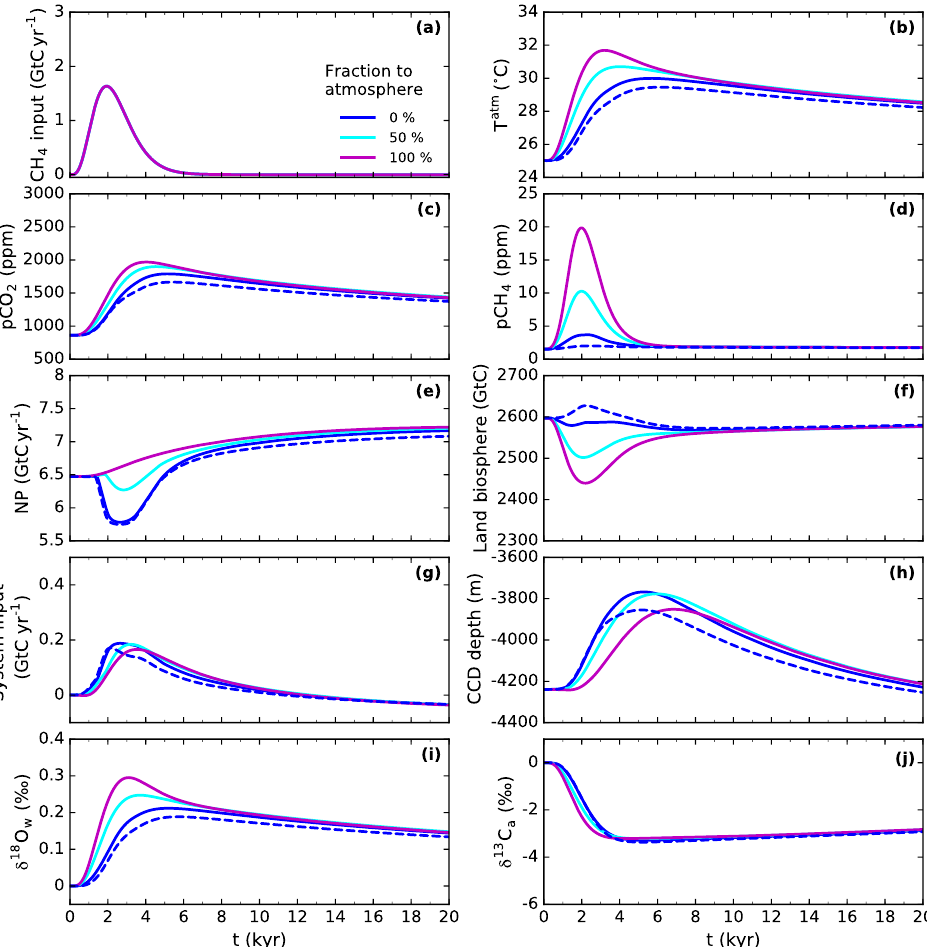
Figure 9. Results for 20000-year simulations for different fractions of methane escape to the atmosphere for a methane input of 4000GtC over a timescale of 3000 years. Properties plotted in (a–j) as in Fig. 7. Also shown are results from a simulation with all methane input to the ocean (0% fraction to atmosphere) and a much shorter ocean methane lifetime of 3 months (dashed blue lines; see main